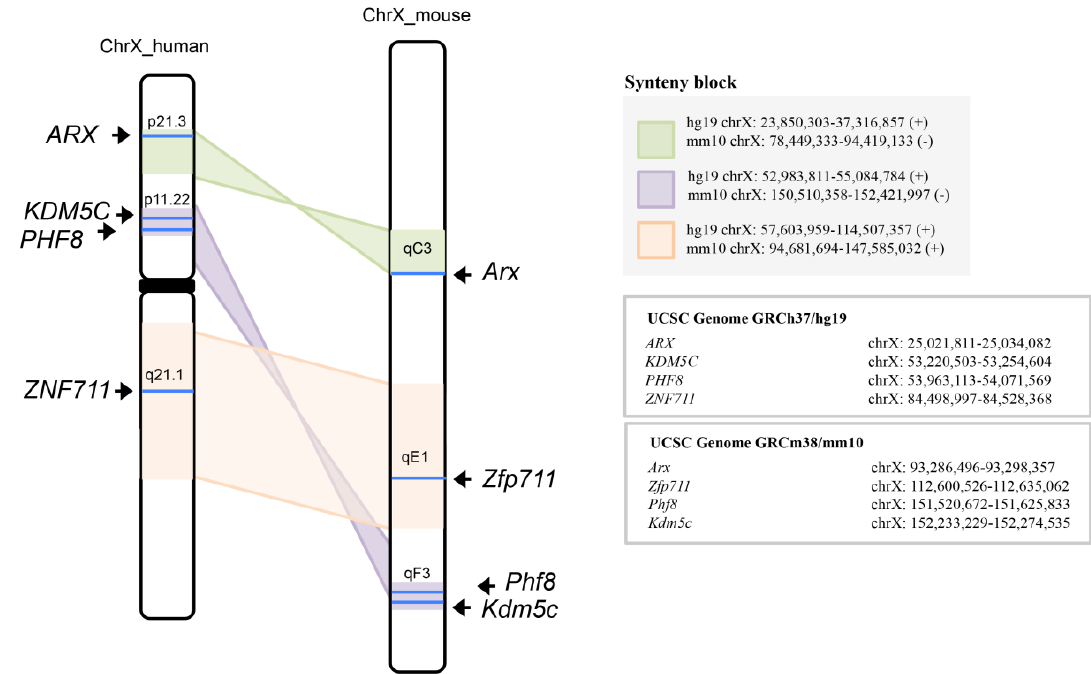
Figure 4. KDM5C , ARX , PHF8 , and ZNF711 are located in syntenic segments of human and mouse X chromosome (ChrX_ human and ChrX_mouse, respectively). SynBrowser map of the human and mouse X chromosome and the regions containing the genes (not to scale; http://bioinfo.konkuk.ac.kr/synteny_portal/, accessed on 1 May 2021) . Block linkages in the same orientation are labelled in pink (ChrX human Xq21.1 vs. ChrX mouse XqE1), while those in inverted orientation are labelled in green (ChrX human Xp21.3 vs. ChrX mouse XqC3) or in violet (ChrX human Xp11.22 vs. ChrX mouse XqF3). Nucleotide positions of each block are